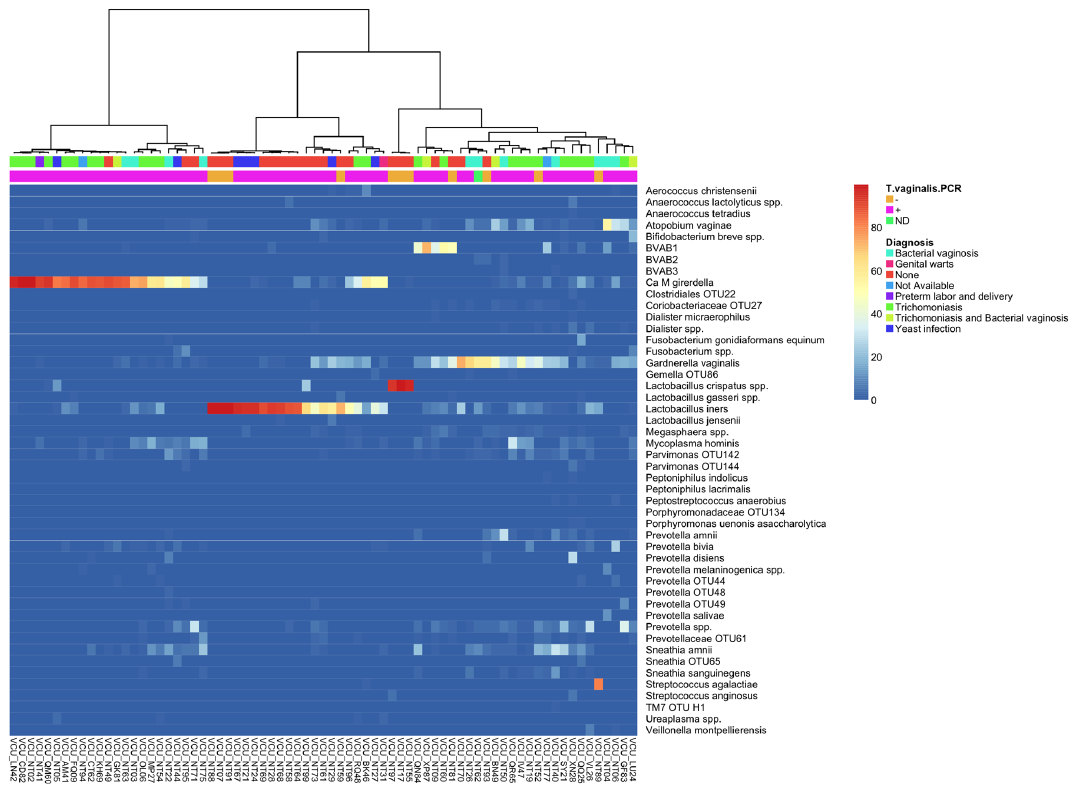
Figure 2. Cluster analysis of mid-vaginal samples positive for ‘‘ Ca . M. girerdii’’. Relative abundance of microbial taxa in mid-vaginal bacterial communities of ‘‘ Ca. M. girerdii’’ positive women is shown. The dendrogram was generated using Ward’s method with Manhattan distance. This analysis includes only mid-vaginal samples that exhibited at least 0.1% ‘‘ Ca . M. girerdii’’ by 16S rDNA profiling. Clinical diagnosis is indicated in the first bar, and presence of T. vaginalis by RT-PCR is indicated in the second bar (orange designates a negative result and pink designates a positive result). The three samples dominated by L. crispatus and the three samples with the highest prevalence of L. iners were negative for T. vaginalis .